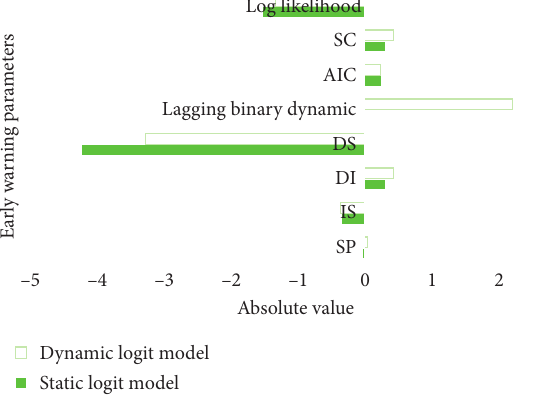
Figure 3: Estimation results of the early warning